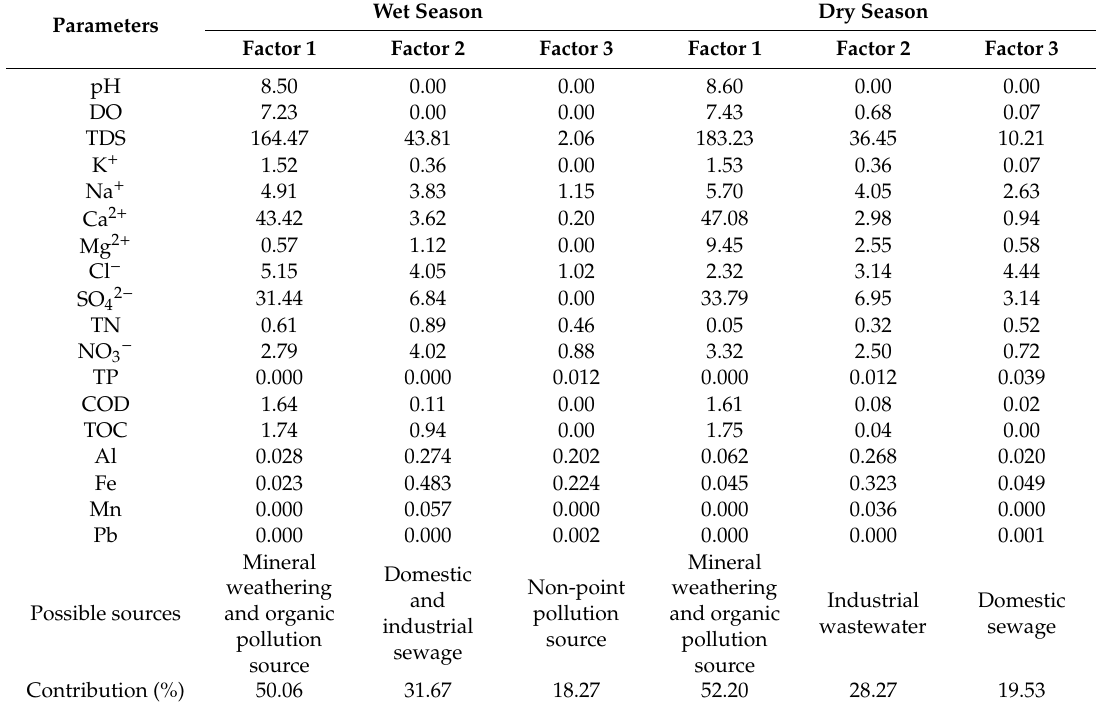
Table 3. Source profiles obtained from the positive matrix factorization (PMF)